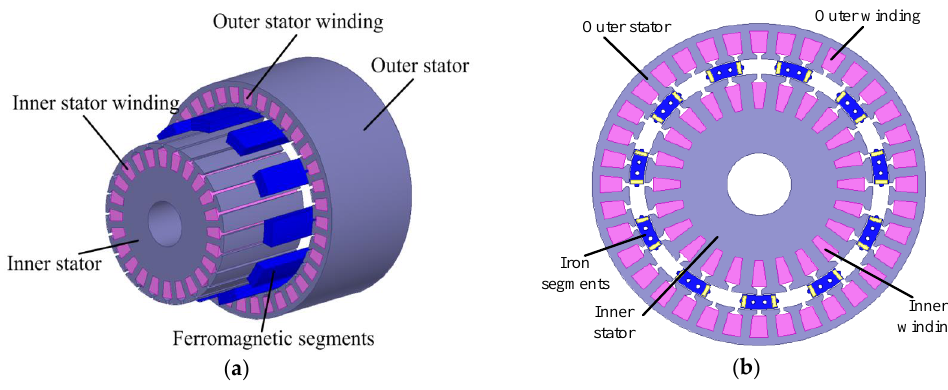
Figure 1. Structure of the DSFM motor with an iron segment rotor: ( a ) 3D model; and ( b ) 2D model.